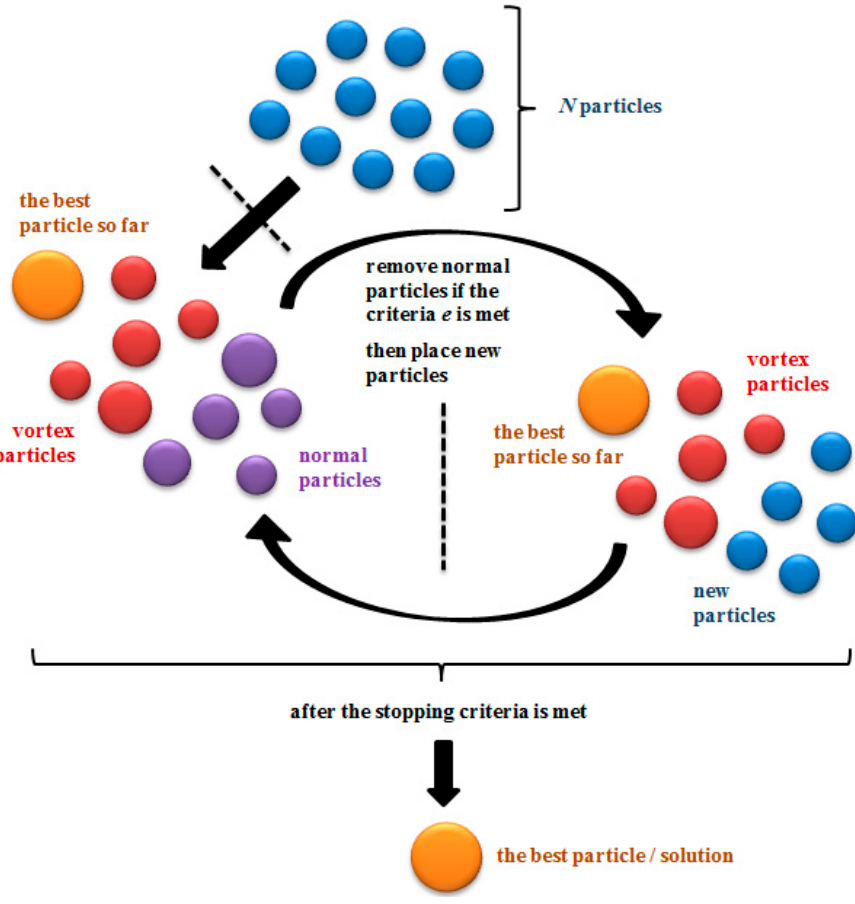
Figure 6. Default solution flow idea under the early vortex optimization algorithm [44].